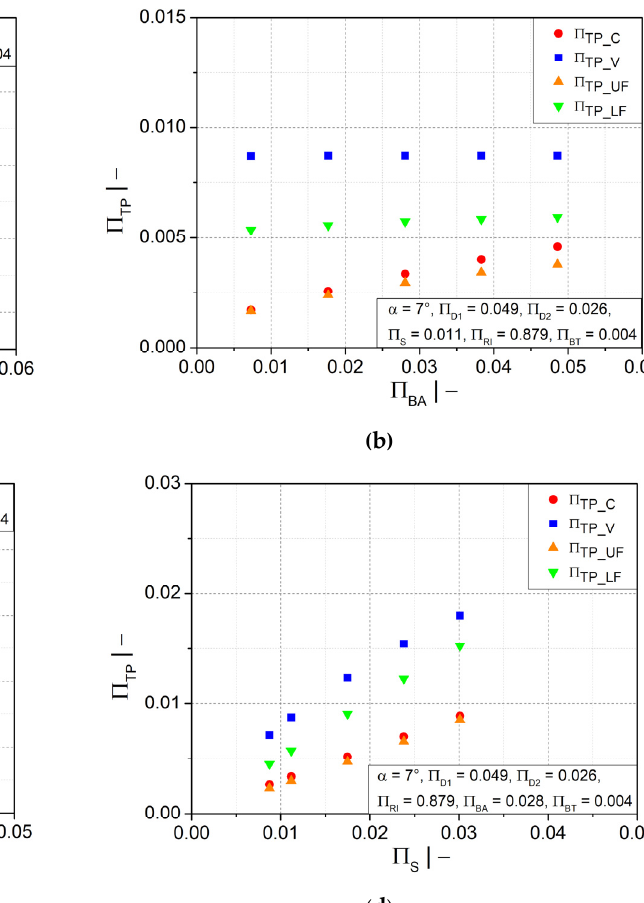
Figure 10. Ratio of wall thicknesses at crest and valley and dimensionless wall thickness as functions of dimensionless ( a , b ) half profile width at crest ∏ B